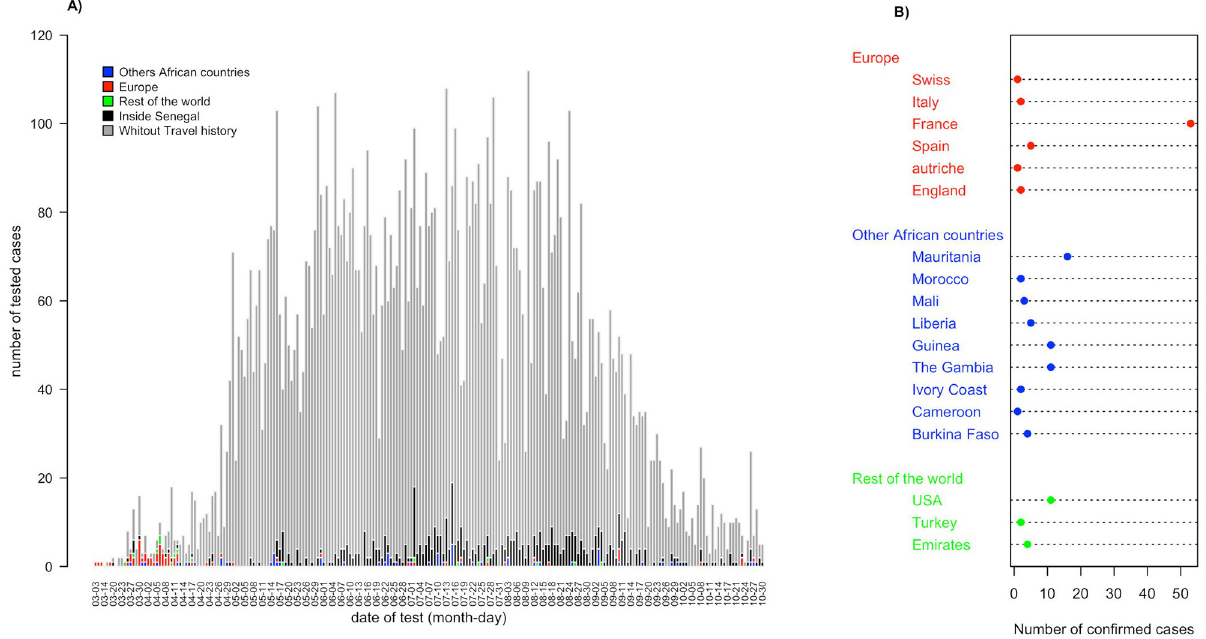
Fig 2. Confirmed COVID-19 cases according to their travel history. A. Histogram of COVID-19 cases with and without travel history. Dates of onset are represented in the x-axis and number of tested cases on the y-axis. Grey part of the bars represents cases without travel history, black bars cases circulated inside Senegal, green bars cases from the rest of the world, red bars cases from Europe and blue bars cases from other African countries. B. Country’s origin of imported COVID-19 cases.